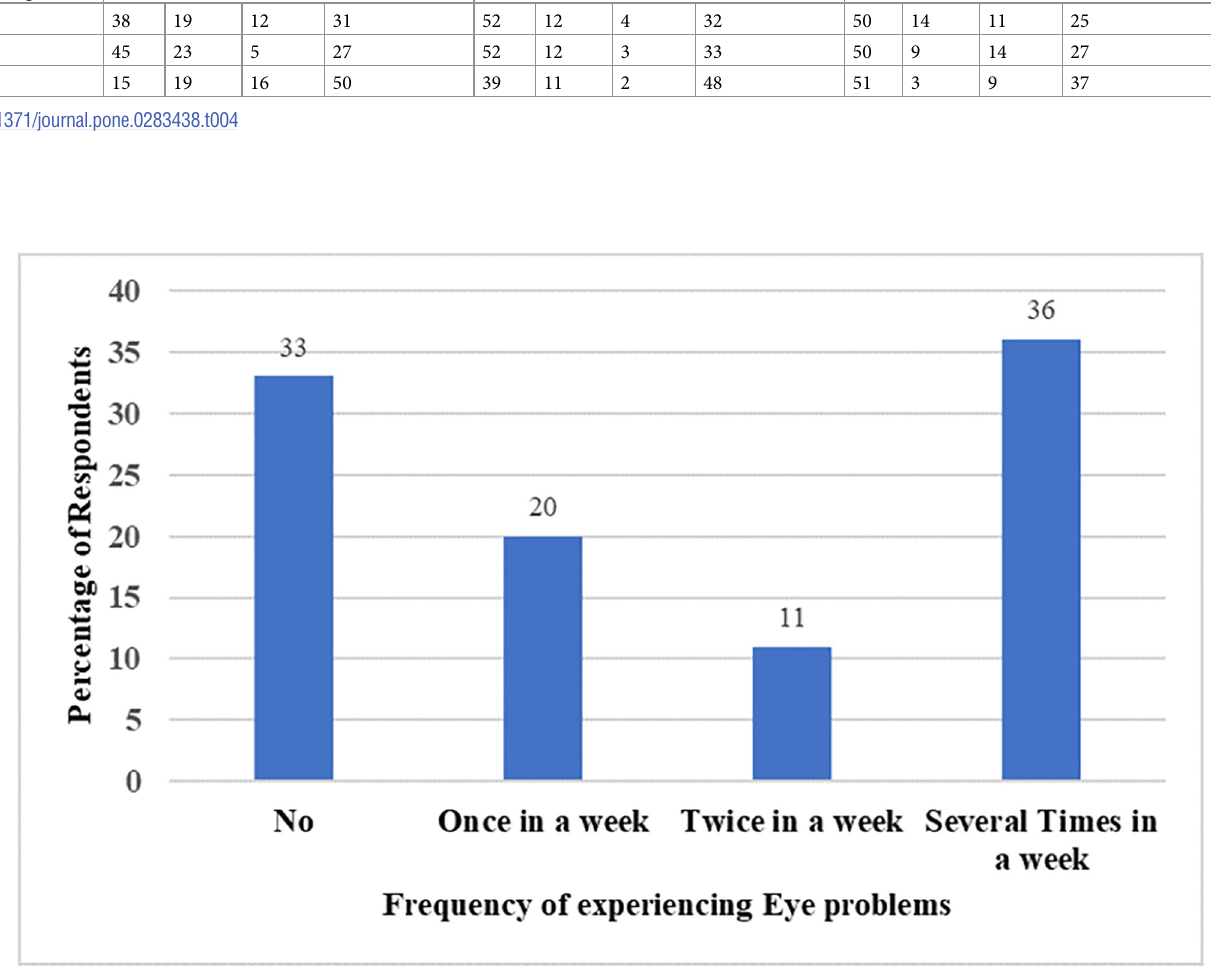
PLOS ONE | https://doi.org/10.1371/journal.pone.0283438 March 24,